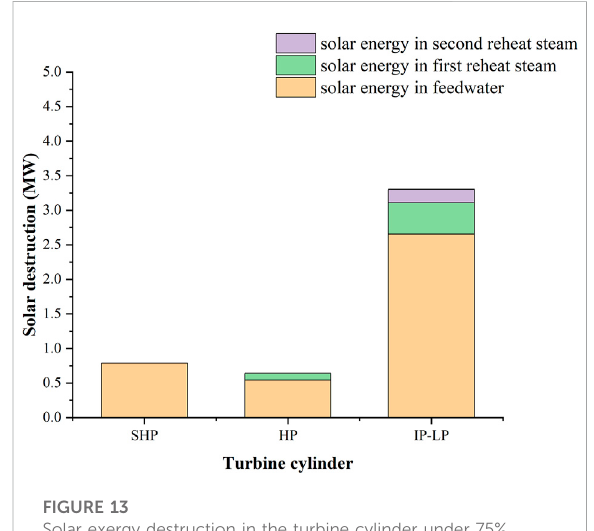
FIGURE 13 Solar exergy destruction in the turbine cylinder under 75% THA load.